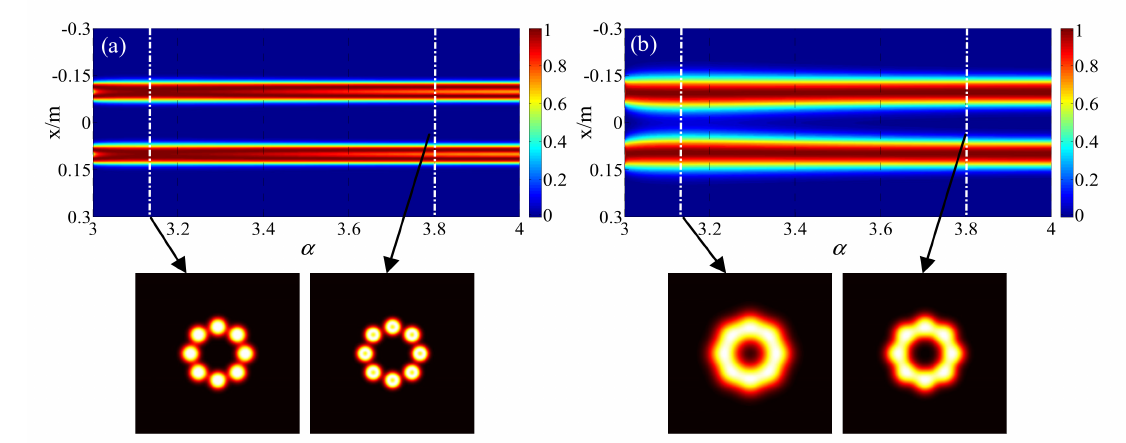
Figure 7. Evolution of intensity distribution of RPLPCV beam array through non-Kolmogorov turbulence versus generalized exponent factor α ( a ) z = 1 km; ( b ) z = 2 km.